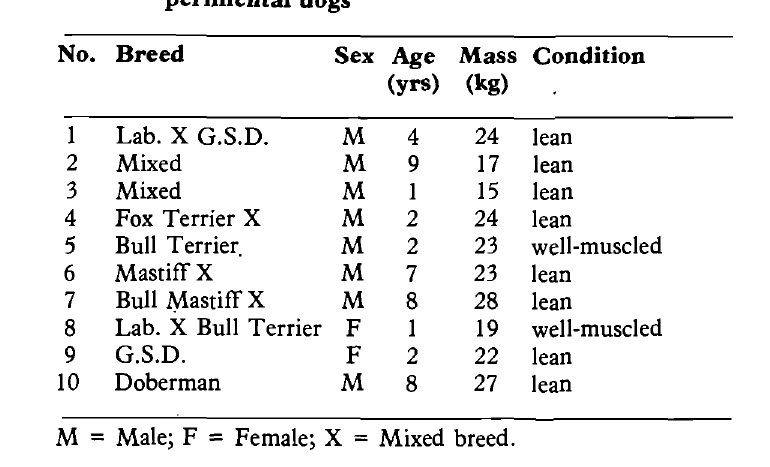
Table 1: Breed, sex, age, body mass and condition of ex- perimental dogs No.